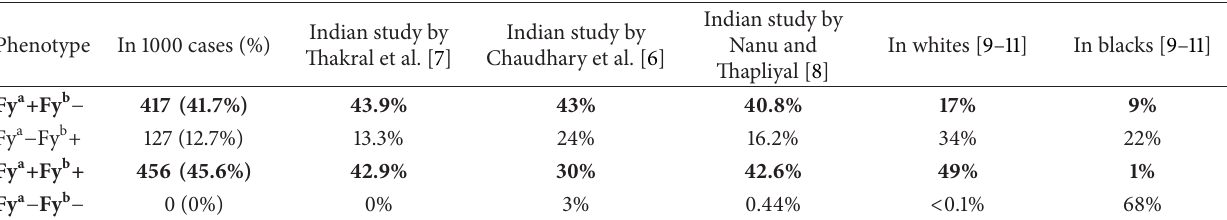
Table 4: Phenotype frequencies of Duffy blood group system.